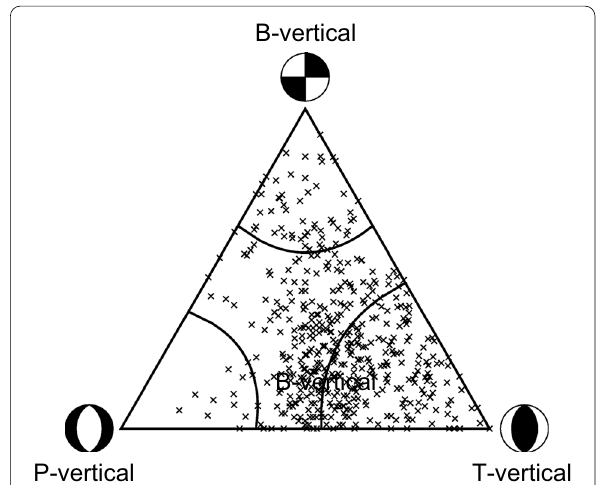
Fig. 6 Triangle diagram displaying the distribution of the focal mechanisms with Quality A and B shown in Fig. 4. Curved lines are boundaries with T, B, and P axes of 40°, 30°, and 30° from vertical,